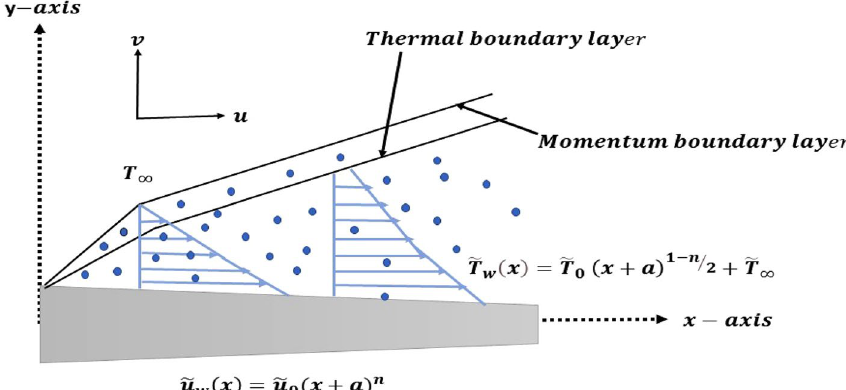
Figure 1. Geometry of the flow